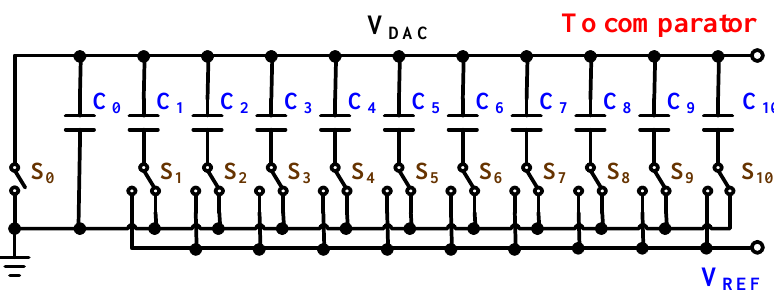
Figure 5. 10-bit binary-weighted capacitive DAC.